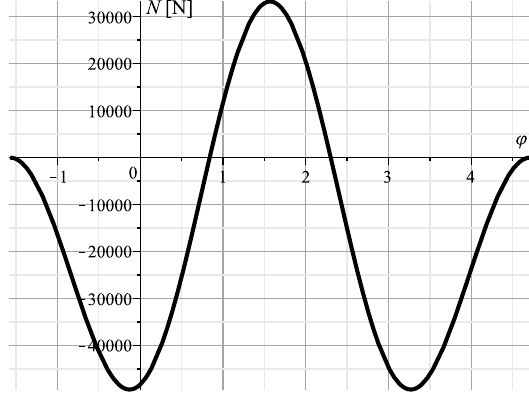
Figure 35: Plot of N ( φ ) (Example 5.4).